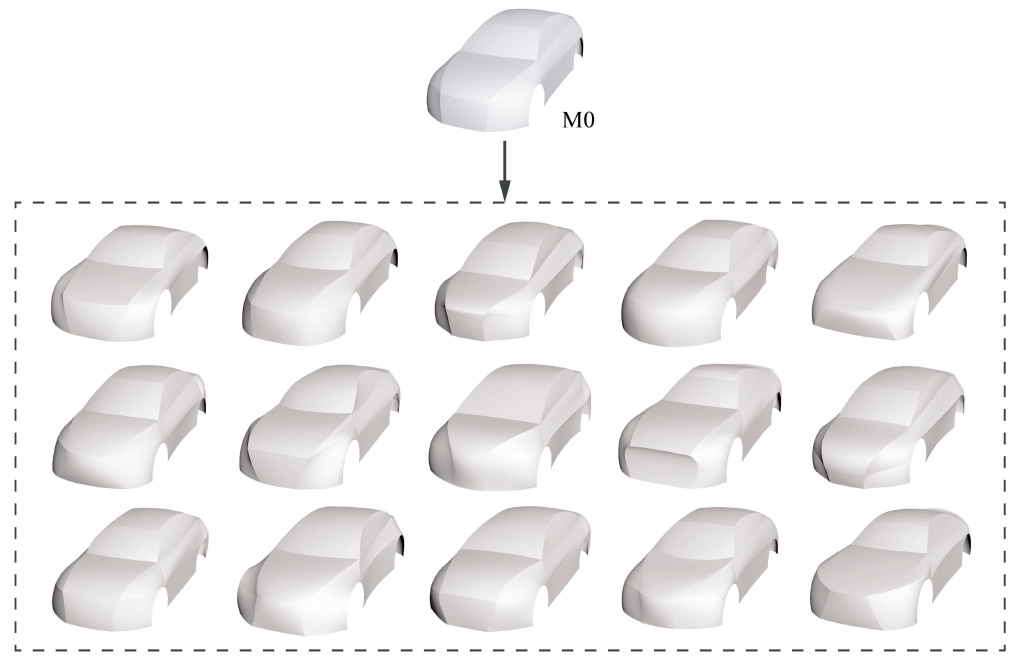
Figure 9. Part M1–M15 in the car sample library built from the model template.